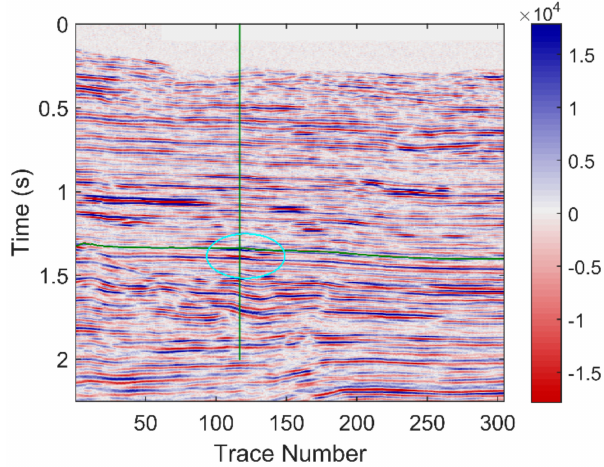
Figure 7. The seismic section from the ZhongJiang Gas